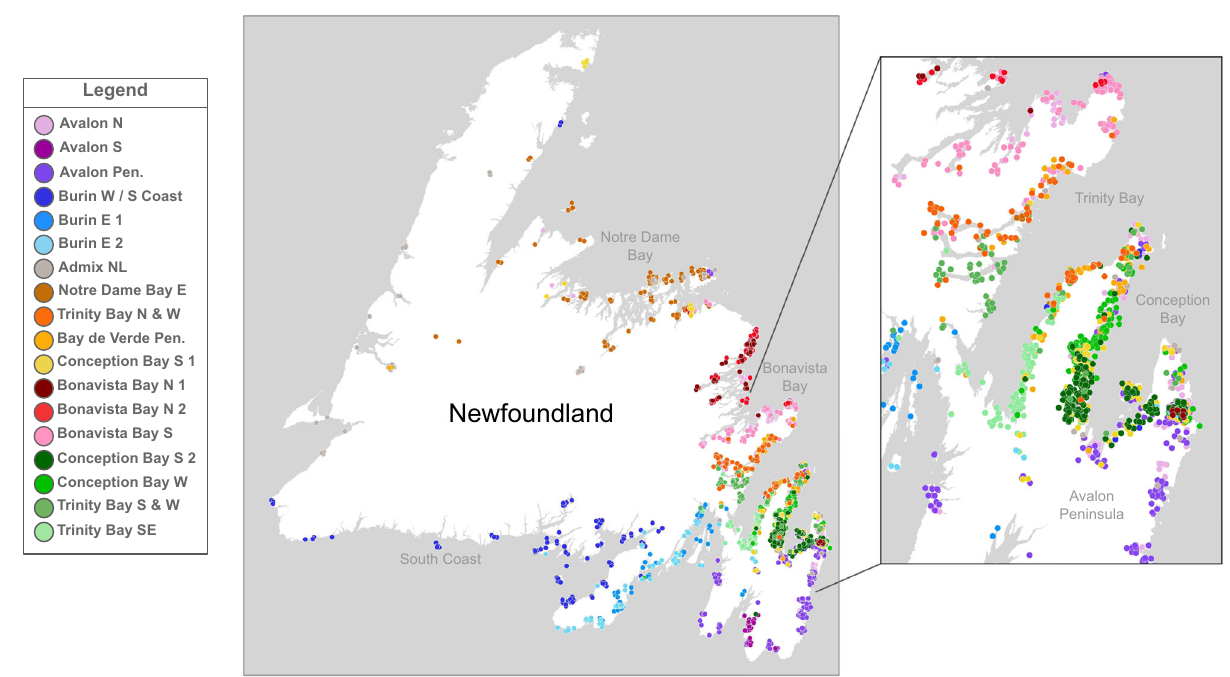
Fig. 2 Genetic landscape of Newfoundland and Labrador. Map of the grandparental birthplaces of individuals with colour and shape coded according to fi neSTRUCTURE cluster. A small jitter has been introduced to aid legibility and preserve anonymity. An insert shows individual details of the Trinity and Conception Bays. Panel was plotted within photoshop, with geography boundary data sourced from